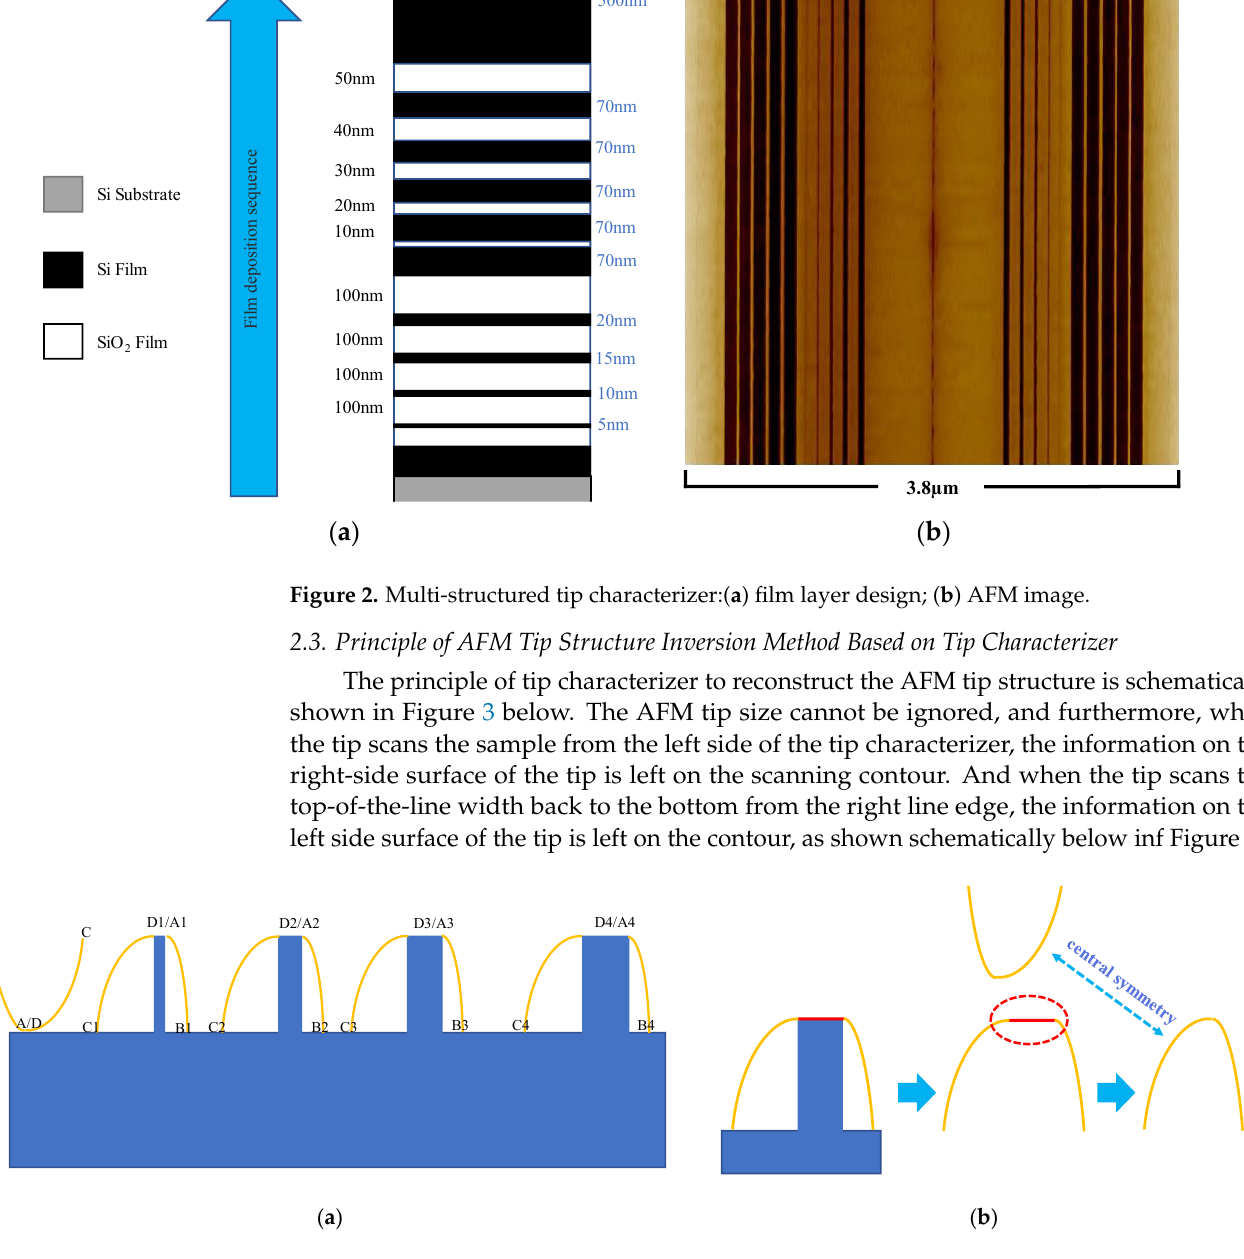
Figure 4. The principle of tip characterizer to reconstruct the AFM tip depth to width ratio. 3. Results 3.1. Tip Characterizer Fabrication and Traceable Measurements According to the multi-structured tip characterizer film structure design in the pre- vious section, the TEM scan pattern of the overall structure of our completed Si/SiO 2 mul- tilayer film grating sample is shown in Figure 5 below. The tip characterizer was fabri- cated by cutting the whole deposited sample into the same size, so the film structure be- tween the samples is almost the same.